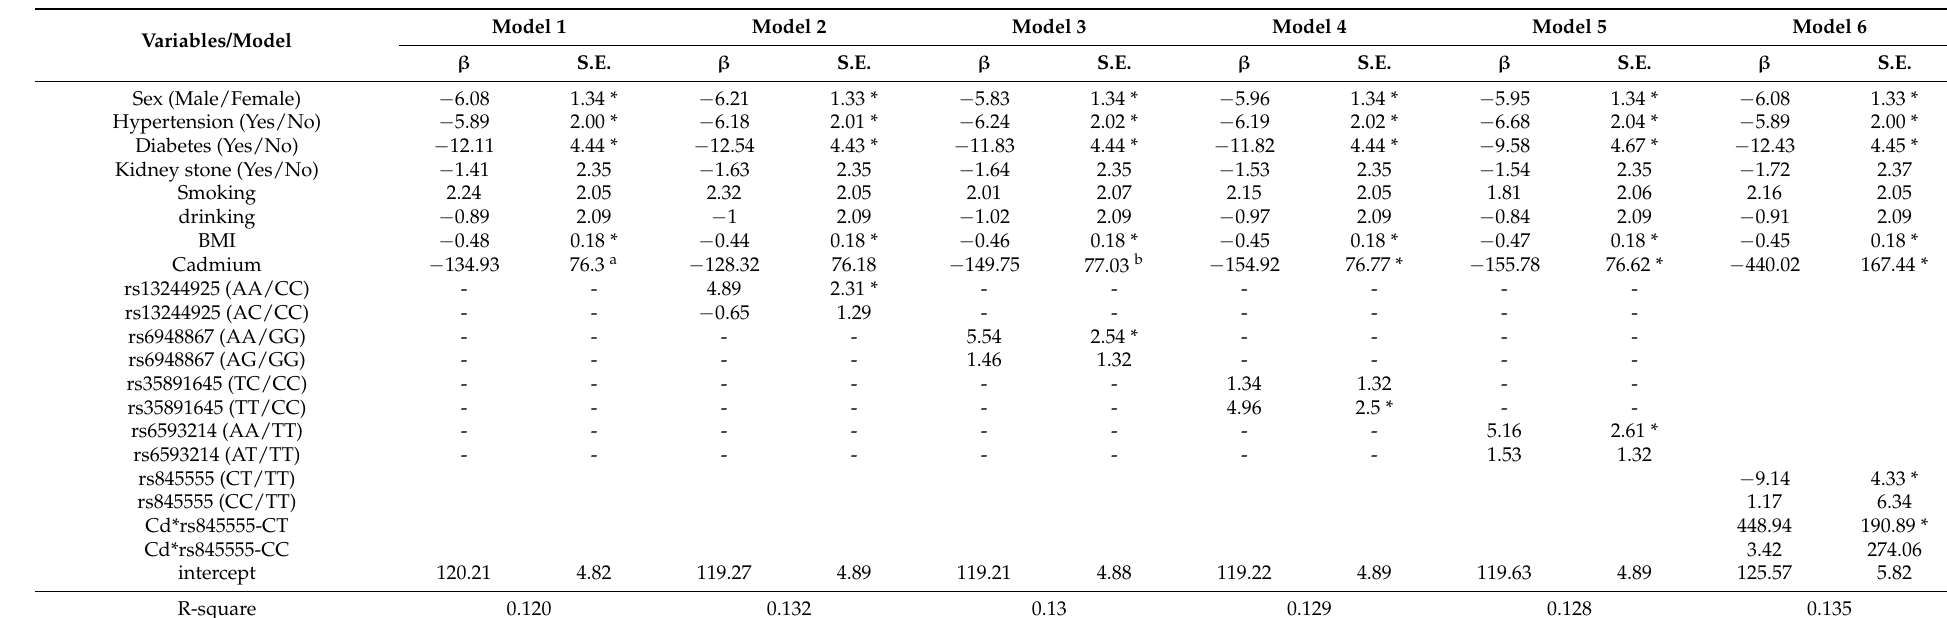
Table 3. Selected general linear regression models of CKD-EPI associated with plasma cadmium and SNP